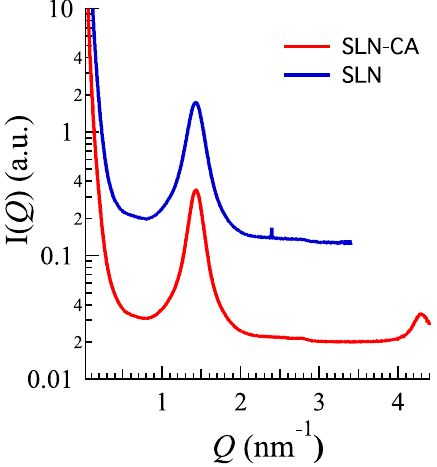
Figure 2. X-ray scattering profile for SLN (blue) and SLN-CA (red) samples. The SLN sample has been measured only up to Q = 3.5 nm − 1 , so that the third order is not observable. Experiments were performed at Diamond Light Source (UK).